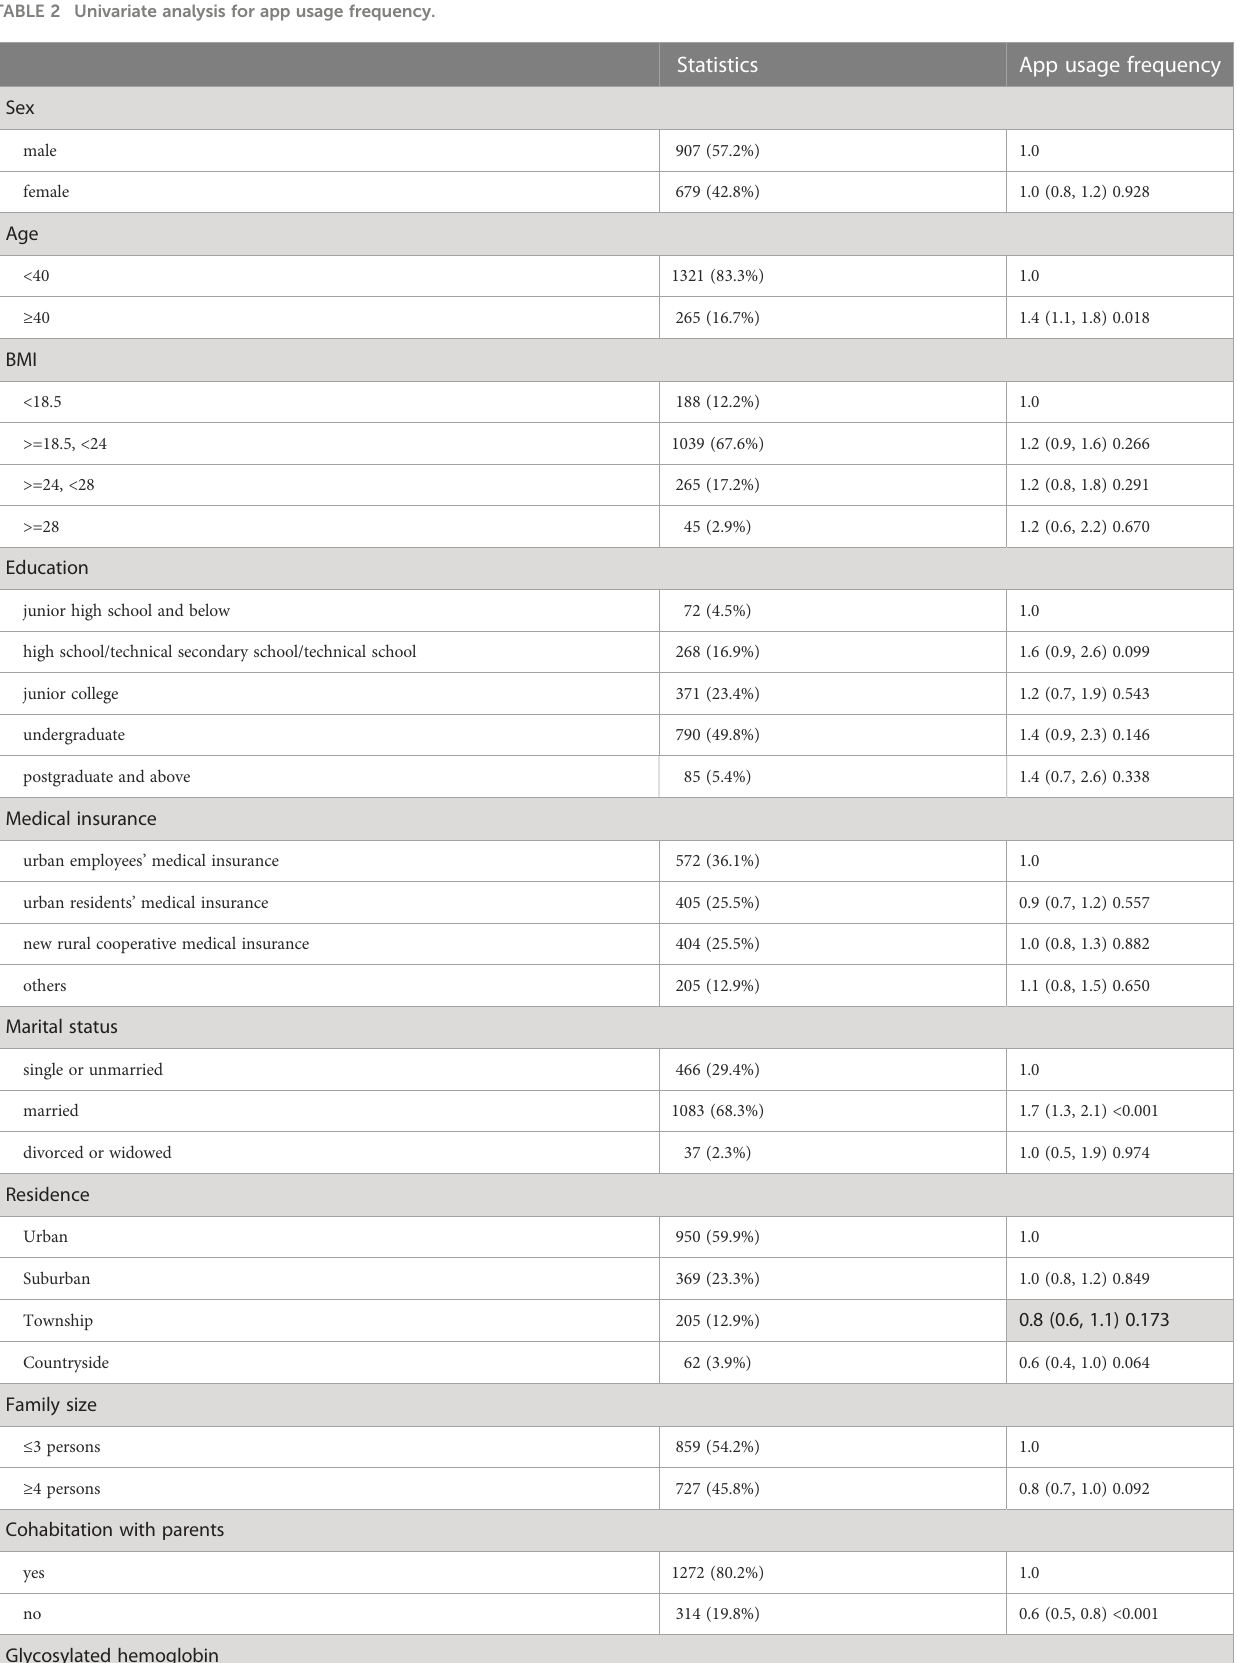
TABLE 2 Univariate analysis for app usage